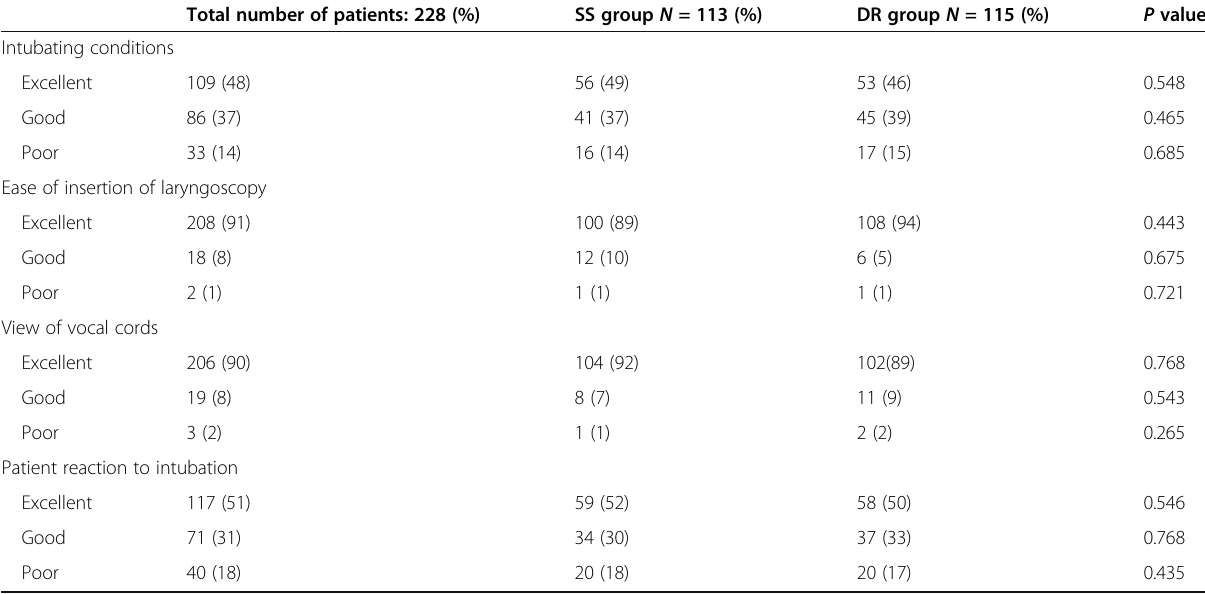
Table 3 Total Intubating conditions between studied